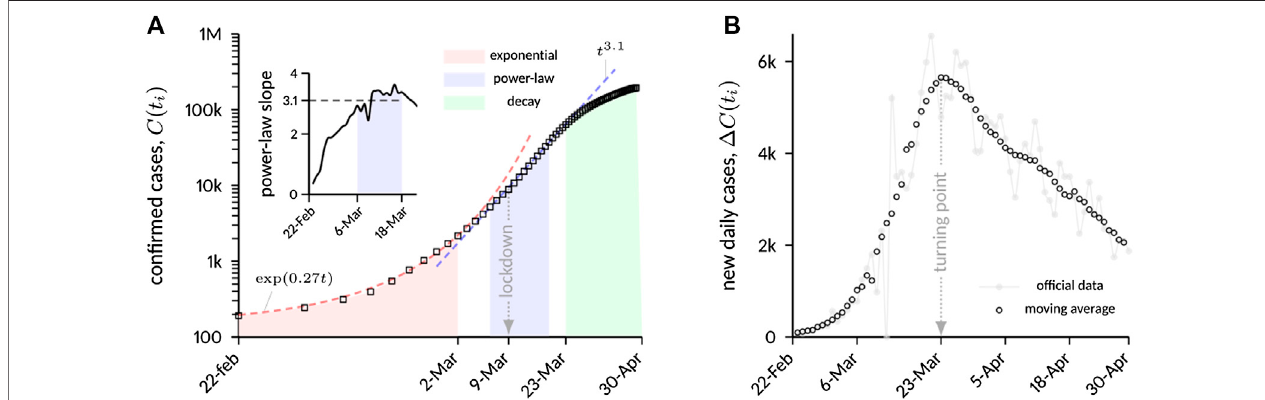
FIGURE1|(A) Cumulativenumberoflaboratory-con fi rmedCOVID-19infectionsinItaly.Amovingaveragewithatimewindowof7 dayswasappliedtothedatato fi lterweekly fl uctuationsincase reporting. Afteraninitialexponential growth, on March6theincreasestartstofollowascaling law t α withaverage α ≈ 3 . 1. (B) Numberof new daily cases of laboratory-con fi rmed COVID-19 infections in Italy. The turning point is highlighted. Gray circles represent of fi cial data, highlighting fl uctuations in data reporting, while black circles were obtained with a 7-days moving average.